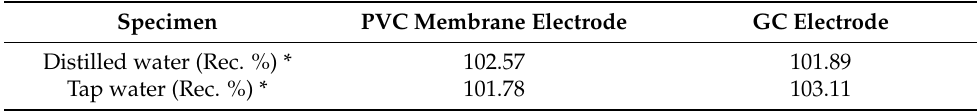
Table 5. Determination of ALN in spiked water samples using the proposed